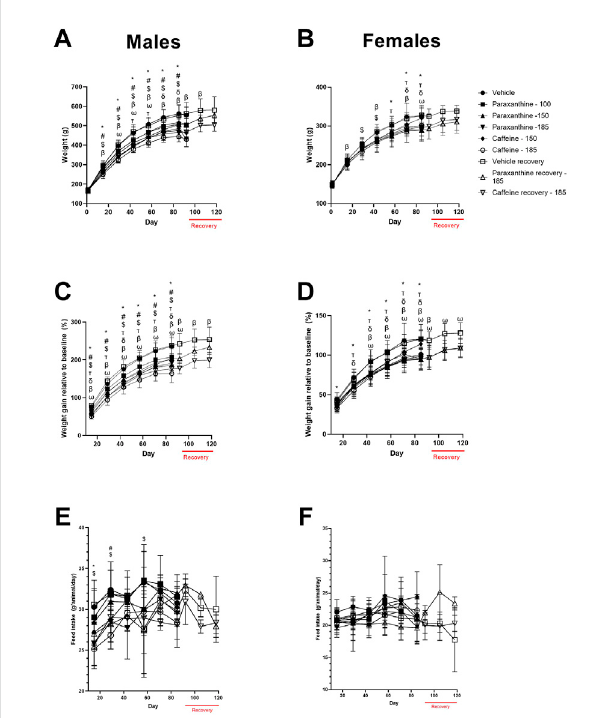
FIGURE 5 Summary of body weight (A, B) , body weight gain (C, D) , and feed consumption data (E, F) for males and females in the repeat-dose 90- day toxicity study. p < 0.05 relative to the vehicle control for 100 mg of paraxanthine/kg bw ( δ ); 150 mg of paraxanthine/kg bw (T); 185 mg of paraxanthine/kg bw (*); 150 mg of caffeine/kg bw (#); 185 mg of caffeine/kg bw ($); and recovery animals at 185 mg of paraxanthine/kg bw ( ω ) and recovery animals at 185 mg of caffeine/kg bw ( β